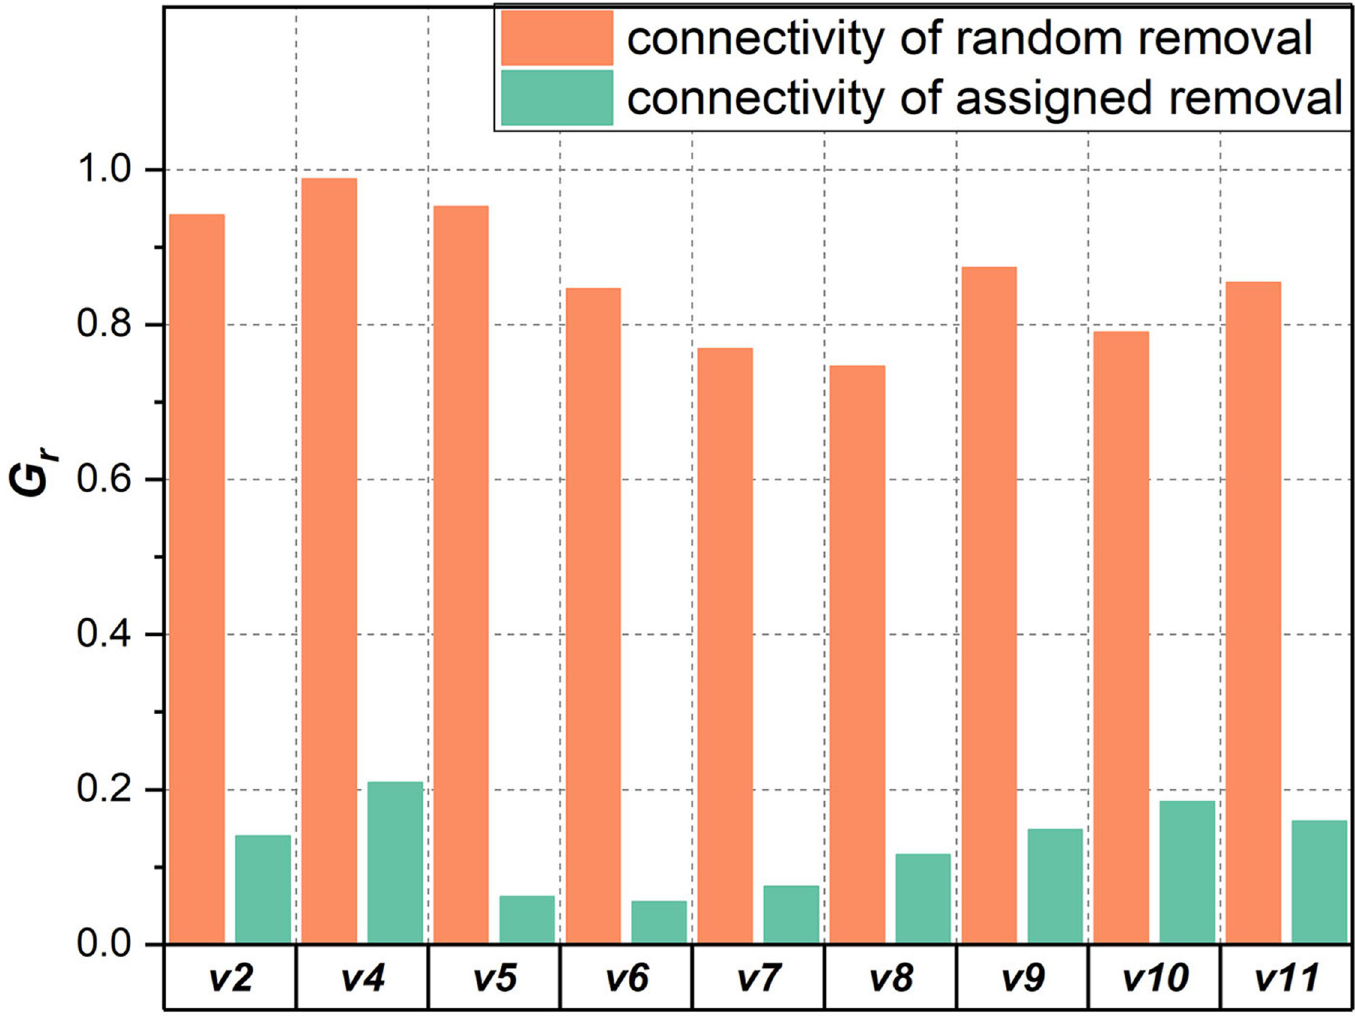
Fig 7. Comparison of the connectivity of the remaining network under random and assigned